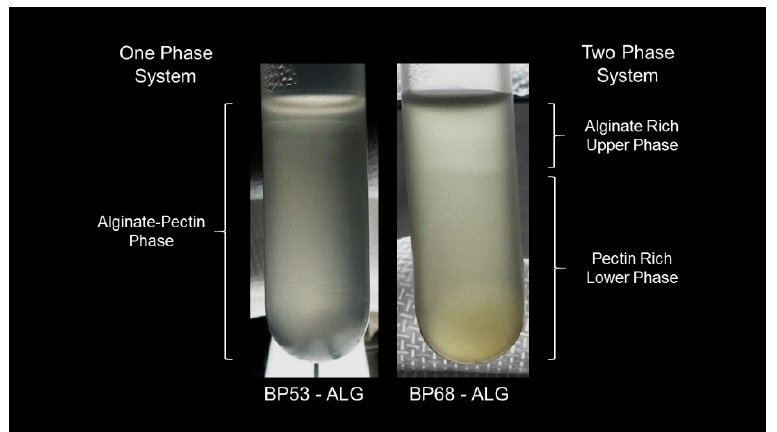
Figure 5. Phase separation behavior of beet pectin–alginate mixtures (10 mM phosphate buffer, pH 7): 2% beet pectin (BP) and 1.5% alginate (ALG).